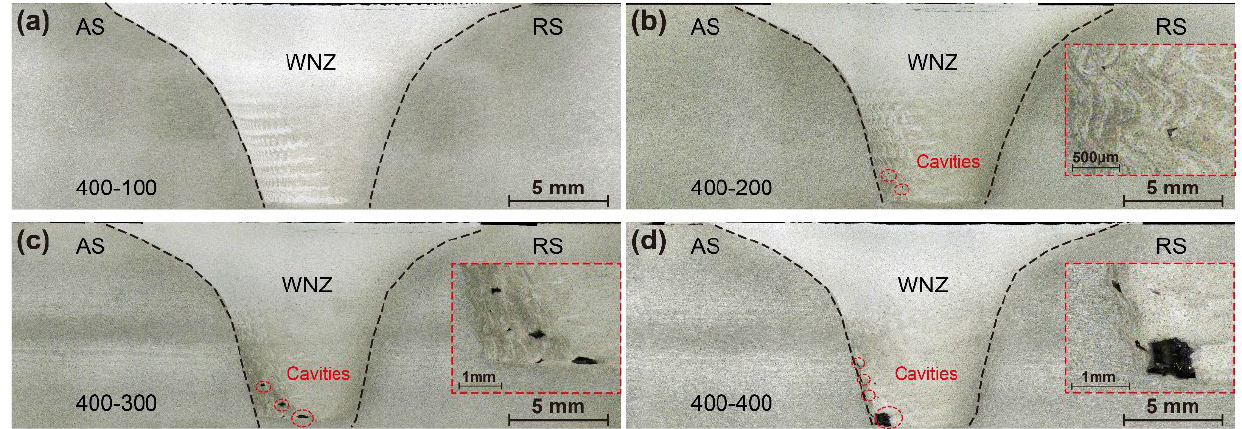
Figure 7. Macrostructure of joints by Pin-1 ( a ) 100 mm/min, ( b ) 200 mm/min, ( c ) 300 mm/min, and ( d ) 400 mm/min.